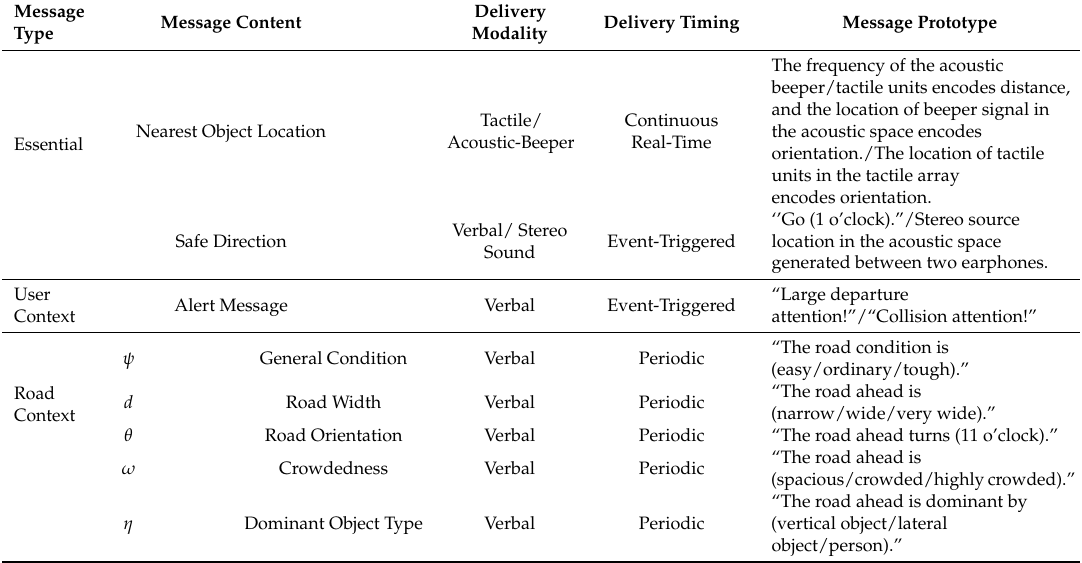
Table 1. Guidance message generation